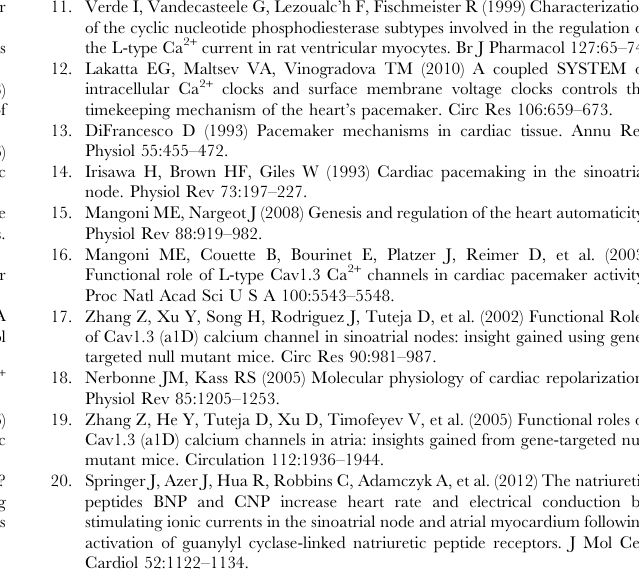
Table S1 Effects of IBMX on spontaneous action potential parameters in isolated mouse SAN myocytes. Table S2 Effects of IBMX on stimulated action potential parameters in isolated mouse right atrial myocytes. Table S3 Effects of EHNA on spontaneous action potential parameters in isolated mouse SAN myocytes. Table S4 Effects of EHNA on stimulated action poten- tial parameters in isolated mouse right atrial myocytes. Table S5 Effects of milrinone on spontaneous action potential parameters in isolated mouse SAN myocytes. Table S6 Effects of milrinone on stimulated action potential parameters in isolated mouse right atrial myocytes. Table S7 Effects of rolipram on spontaneous action potential parameters in isolated mouse SAN myocytes. Table S8 Effects of rolipram on stimulated action potential parameters in isolated mouse right atrial